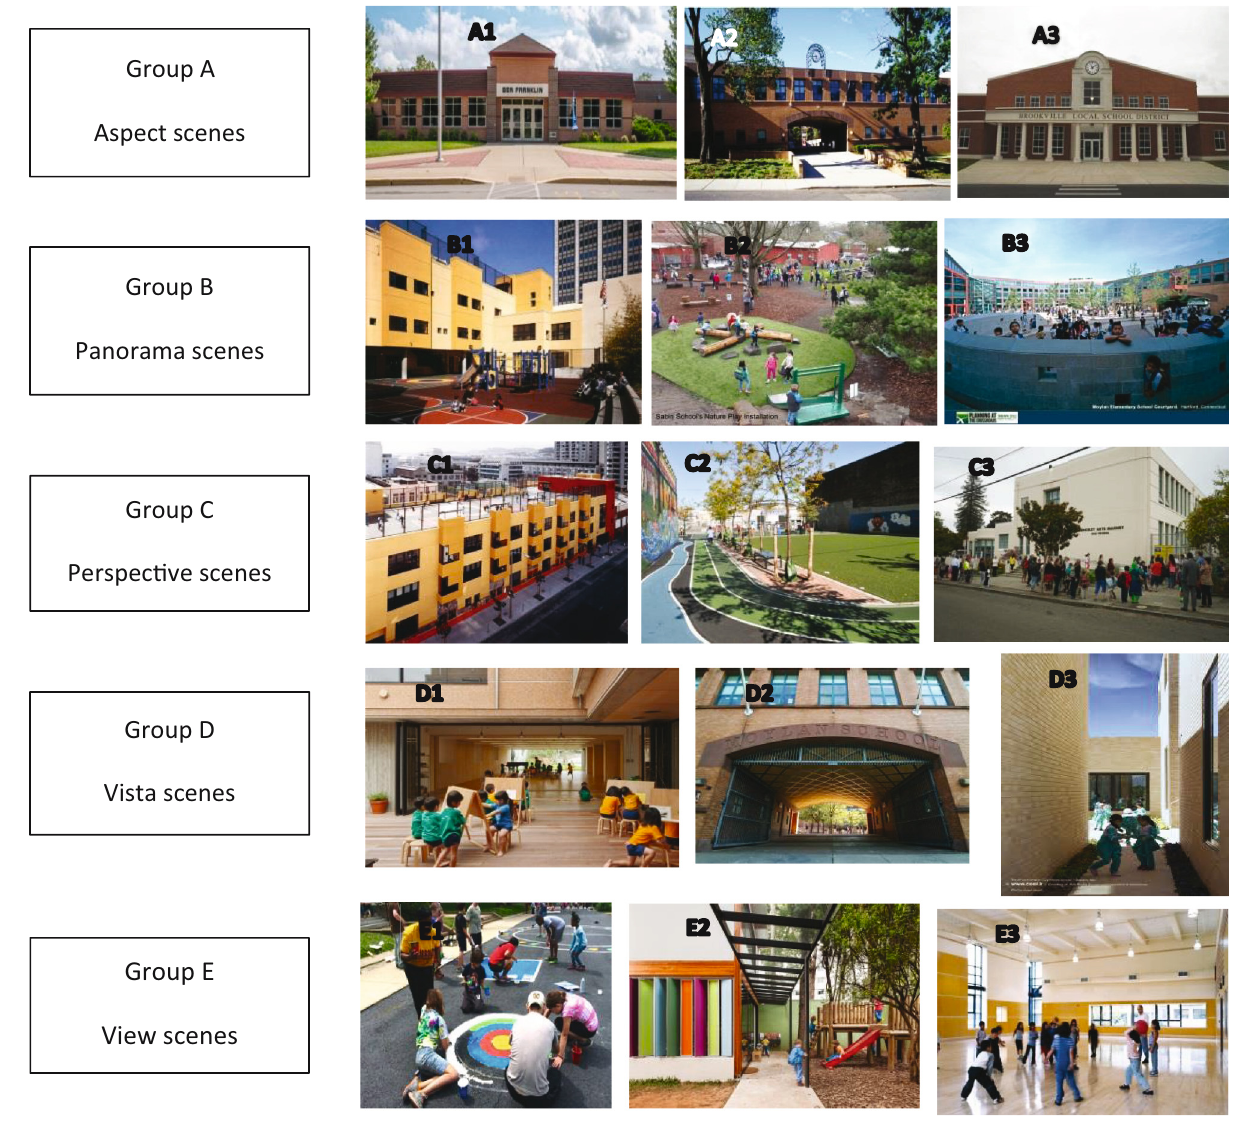
Figure 1: Scenes from global